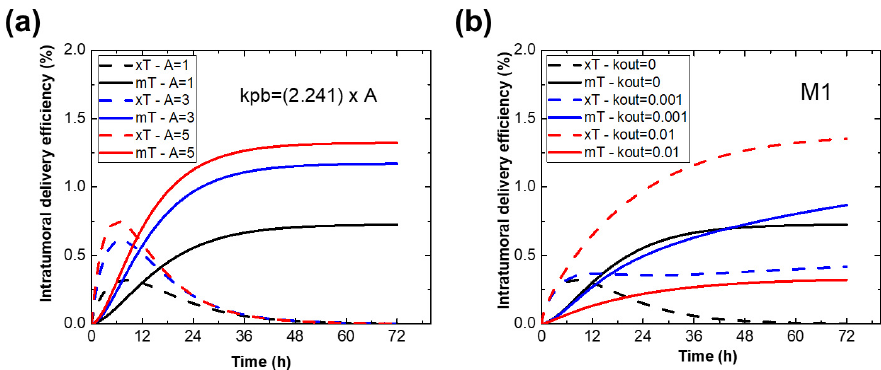
Figure 4. Simulated PK profiles for BNF-Her nanoparticles. Simulated tumor retentions of 100-nm Figure 4. Cont BNF-Her nanoparticles varying several model parameters ( a ) 𝐾 (cid:3043)(cid:3029) , ( b ) 𝐾 (cid:3042)(cid:3048)(cid:3047) from macrophages M1,